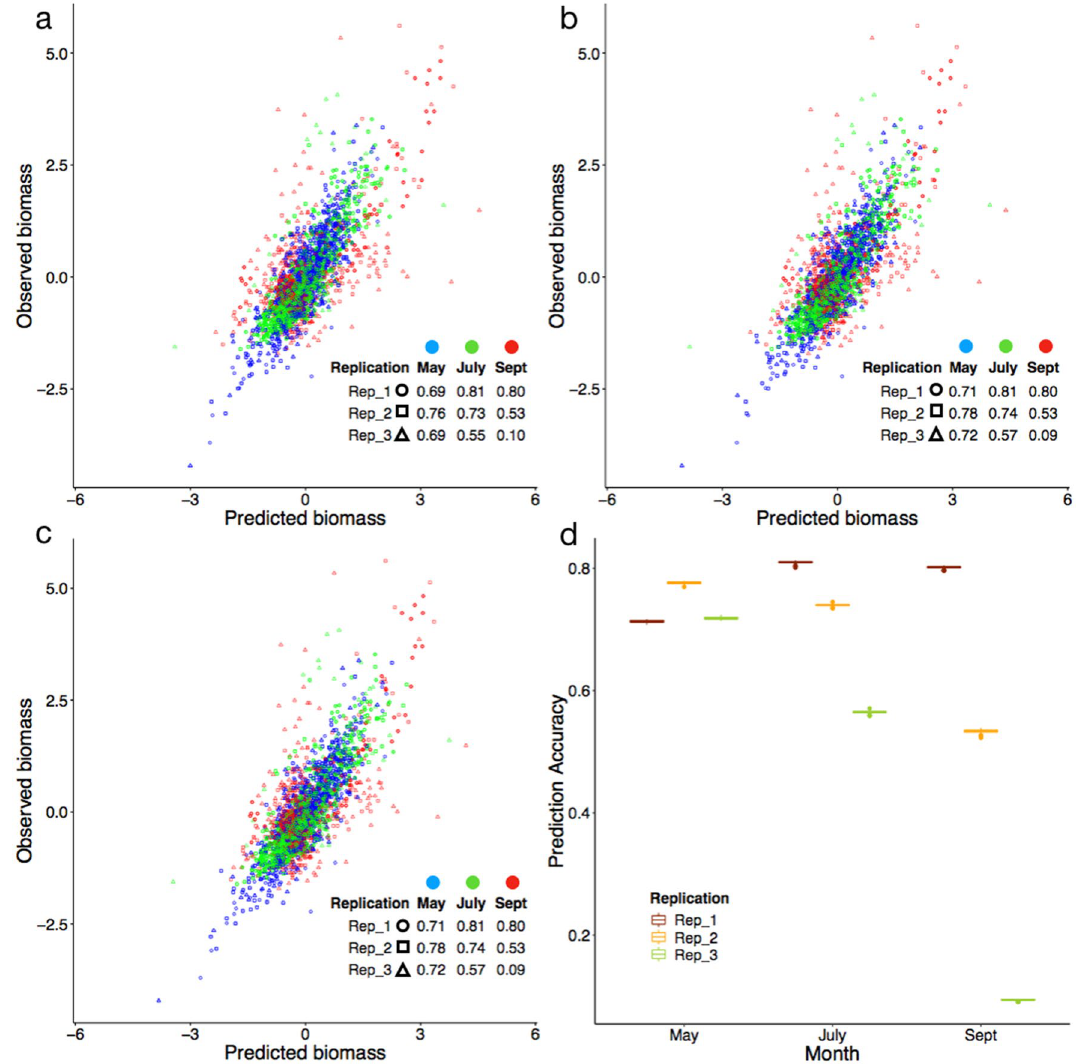
Figure 4. Prediction accuracy under temporal, spatial, and mixed cohort validation. Prediction accuracy was calculated as the coefficient of determination (R 2 ). ( a ) The temporal cohort was based on months (May, July, and September). Two months were selected as the training data and the remaining month was used for validation. The selection process was repeated until all months were tested. ( b ) Similarly, two replicates were selected as training under the spatial cohort with the remaining replicate for validation. The selection process was repeated until all replicates were tested. ( c ) Under a mixed cohort, all plots of three replicates and three months were randomly assigned evenly into three folds. Two folds were used for training and the remaining fold for validation. The process was repeated until all folds were tested. The random assignment was iterated 100 times. One of the iterations was arbitrarily selected for illustration. ( d ) The distribution of the prediction accuracy is demonstrated by the box